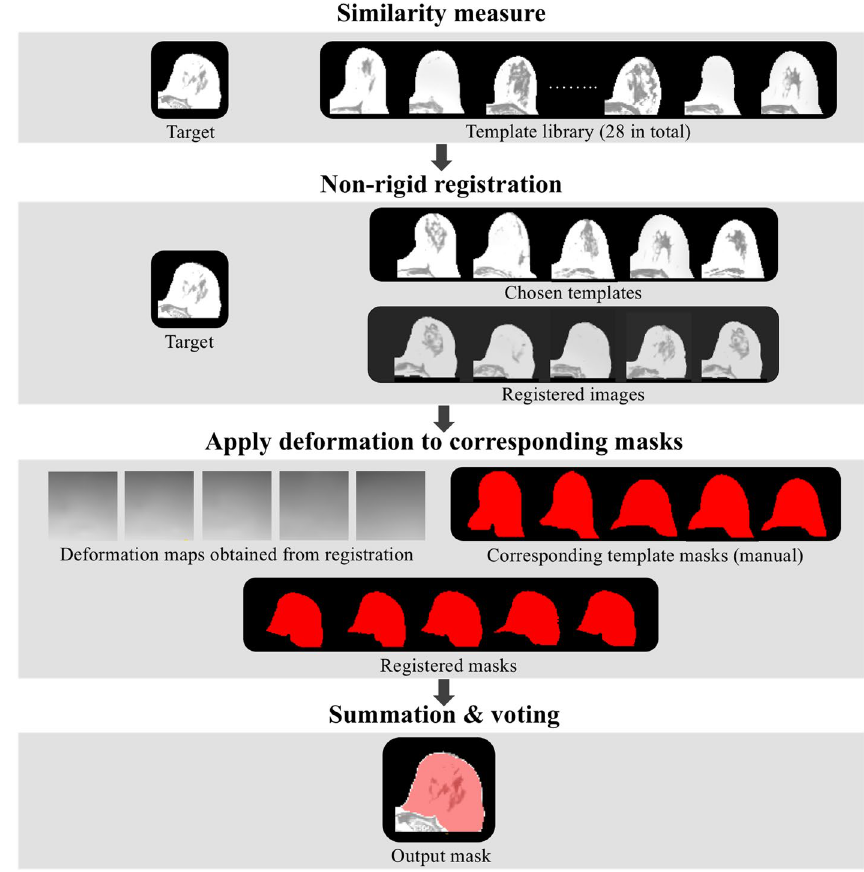
Fig. 2 Pipeline of the registration breast segmentation algorithm. (1) Similarity measurement to choose the most similar five templates; (2) Registration of chosen template images to the target image and generation of deformation maps; (3) Application of the deformation maps to the corresponding template masks; (4) Summation of all the registered masks and voting to output the final segmentation of the breast (voxels contained in at least four registered template masks were